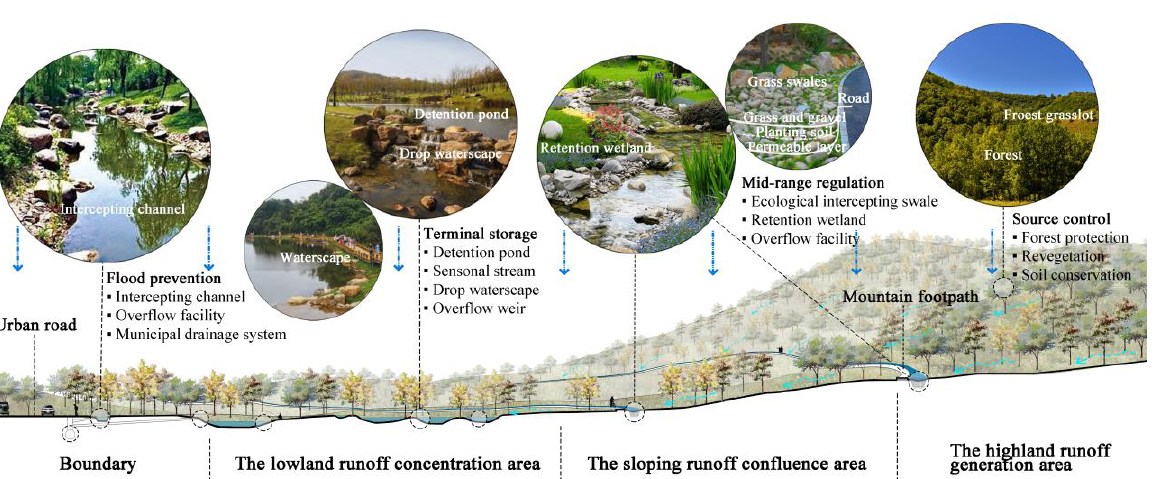
Figure 2. The basic situation of Guanyao Mountain Park.